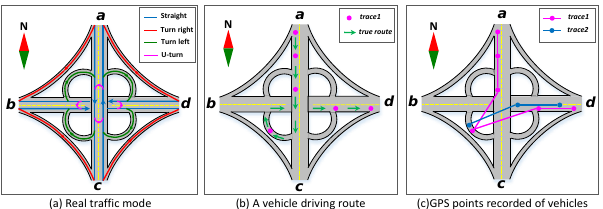
Figure 1. Traffic model at complex road intersections (a: Traffic model; b: Vehicle driving routes from north to east; c: Low- frequency GPS track data of vehicles from north to